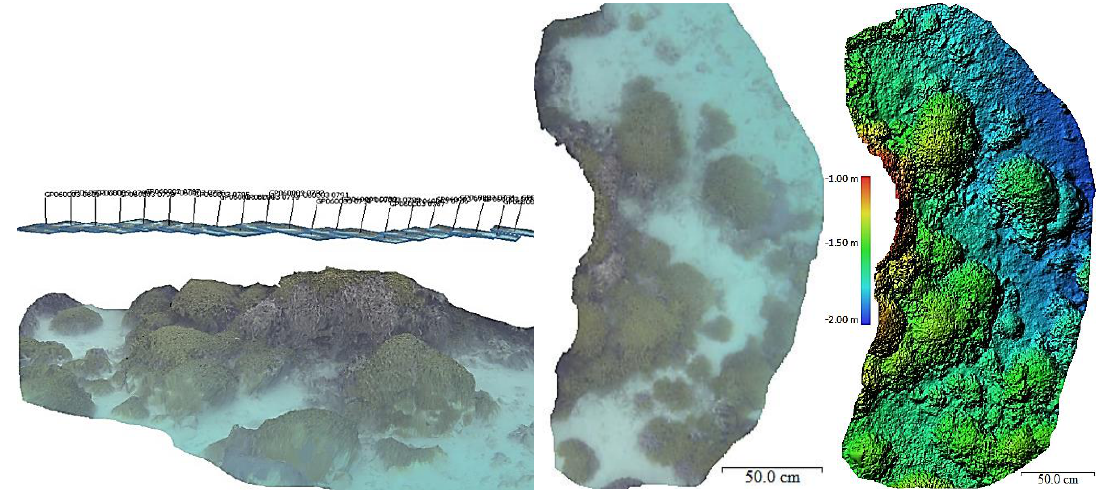
Figure 9. 3D perspective view, orthophoto mosaic, and DTM for a categorized coral sample.